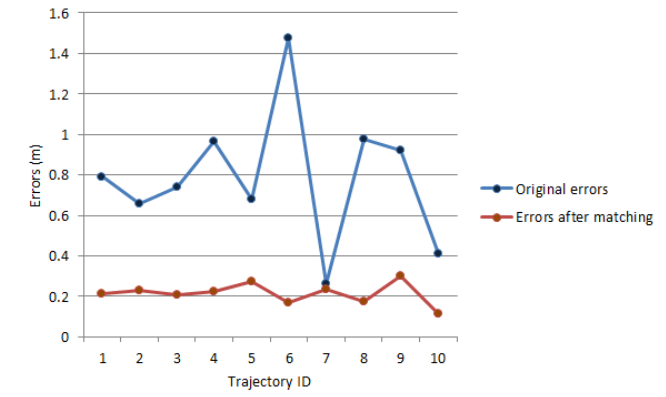
Figure 12. Localization error of the trajectories’ end points.